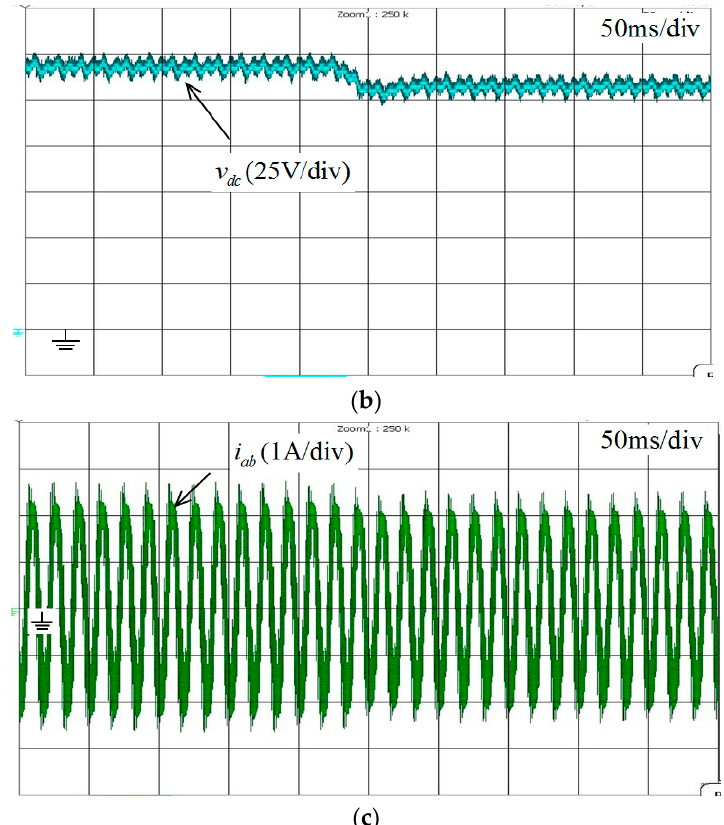
Figure 9. Experimental results for a single microinverter under open-loop control with resistive load. ( a ) PV current; ( b ) dc-bus voltage; ( c ) ac output current.